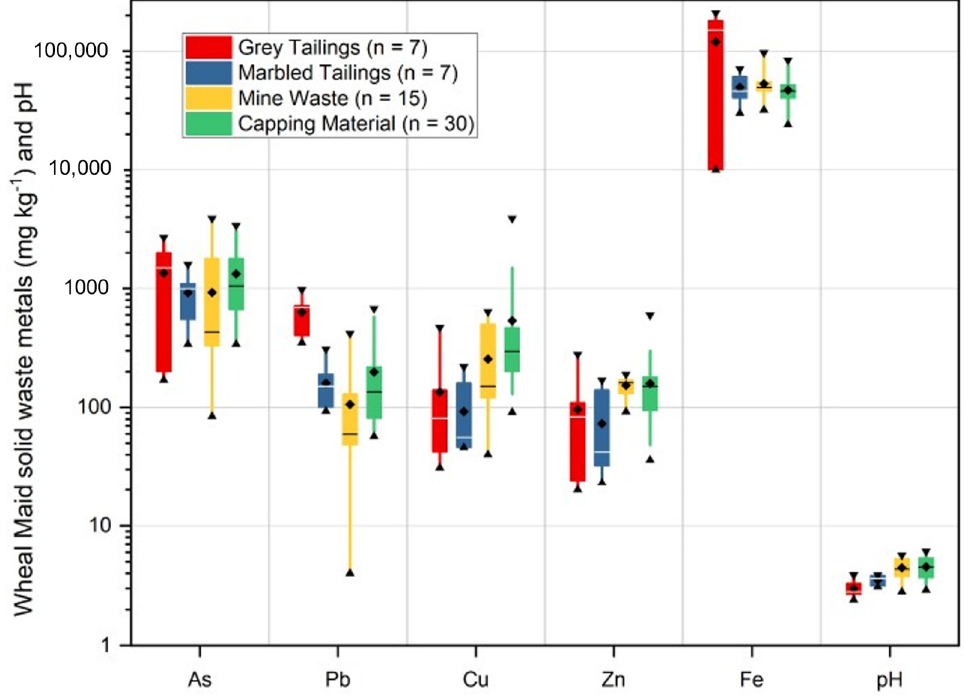
Figure 2. Concentrations of metals and pH in Wheal Maid waste samples (figure drawn from data collected by [1]. The box covers the interquartile range, the line is the median, and the diamond is the mean. The whiskers are drawn at the 5th and 95th percentile, and the maximum and minimum values are shown with triangles.